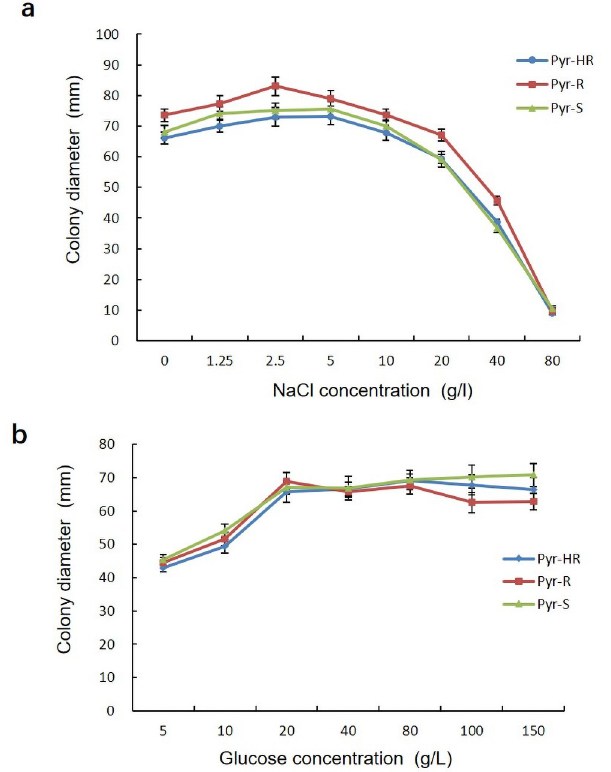
Fig 2. Osmotic stress sensitivity of Lasiodiplodia theobromae to different pyraclostrobin resistance phenotypes. (a) Sensitivity to NaCl. (b) Sensitivity to glucose. Bars denote the stand error of three experiments. S = sensitive, R = resistant, and HR = highly